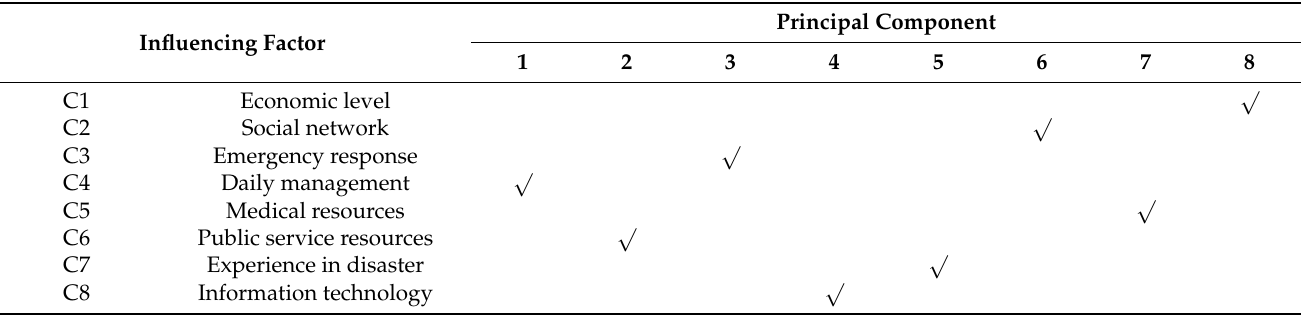
Table 2. Determination of influencing factors of community epidemic